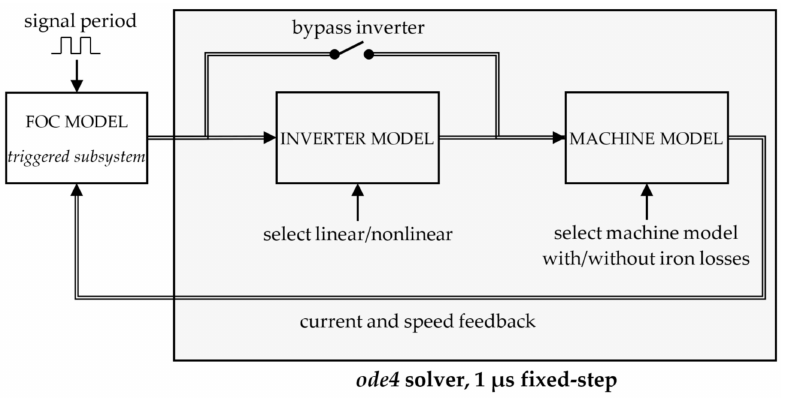
Figure 6. Principal block diagram of simulation